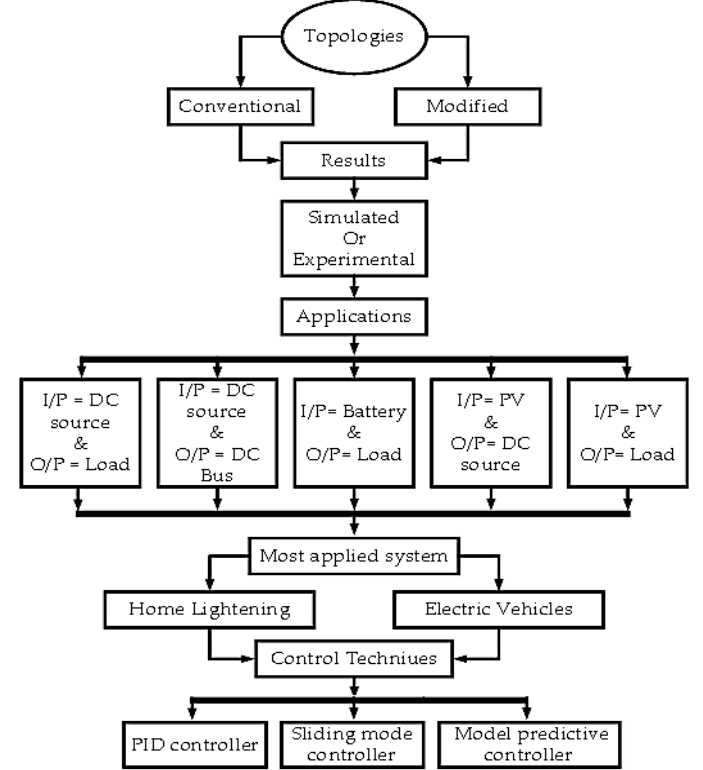
Figure 11. Summary of various control